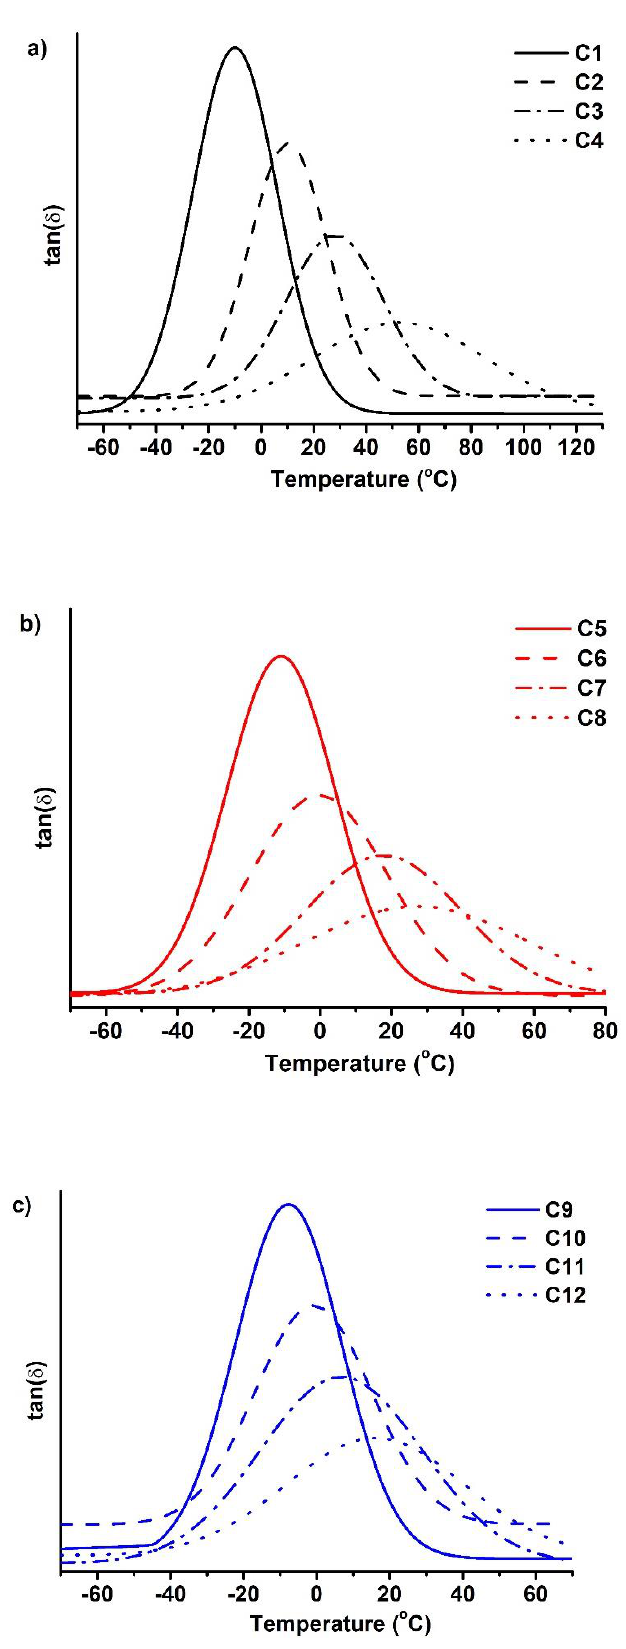
Figure 4. DMTA thermograms of cross-linked polymers C1 – C4 ( a ), C5 – C8 ( b ), and C9 – C12 ( c ).